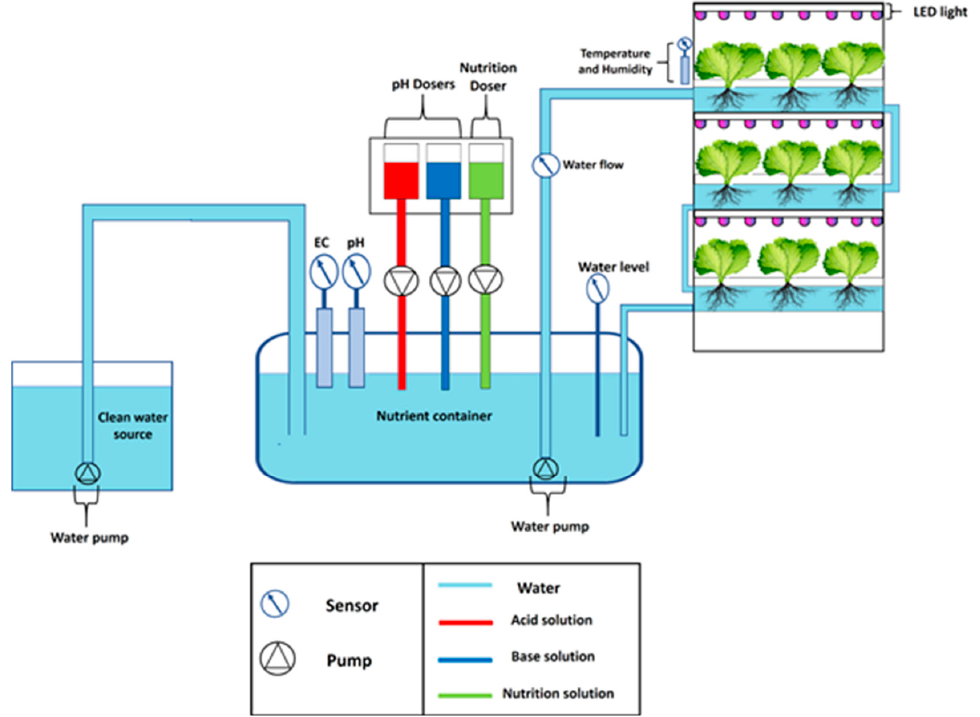
Figure 6. Schematic diagram of the complete system.